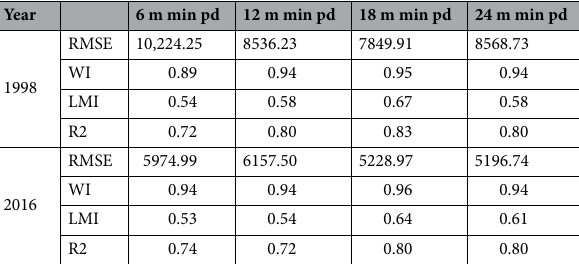
Table 1. Comparison of criteria in Conv encoder–decoder GRU with different periods in Hankou